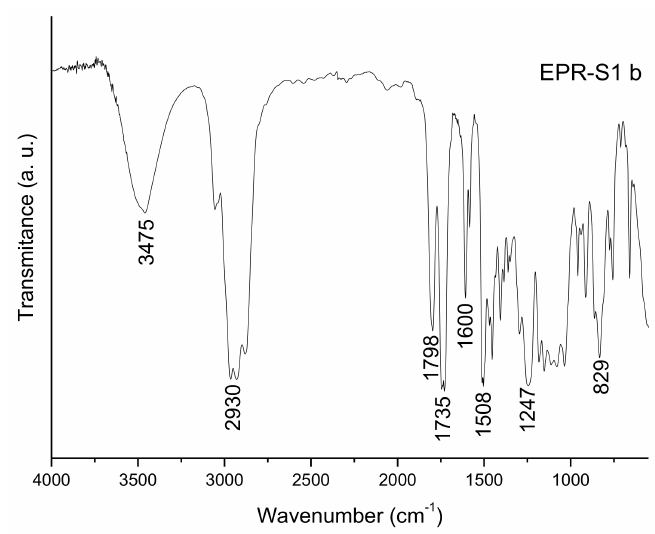
Figure 3. Fourier-transform infrared (FTIR) spectra of sample EPR-S1_b.